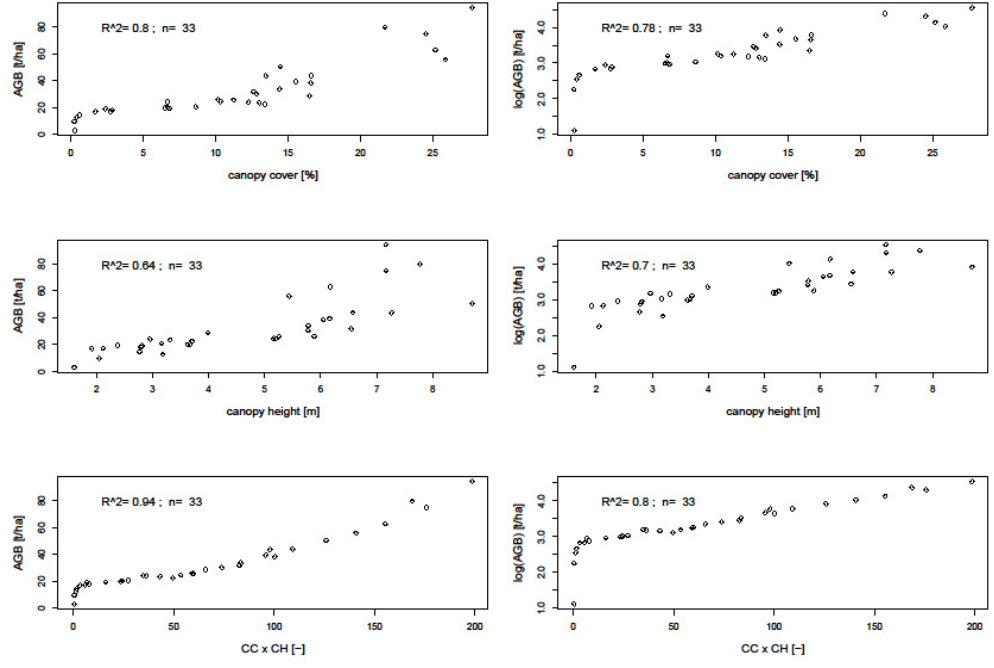
Figure 10. Correlation between TLS canopy cover height metrics and AGB and log (AGB).